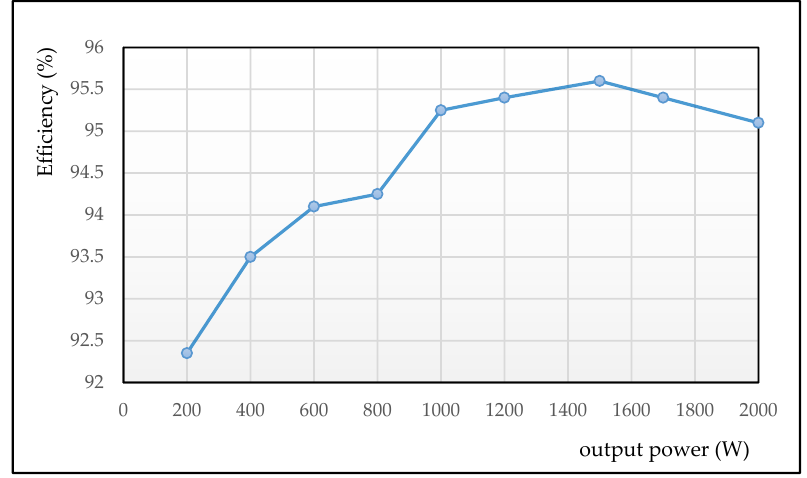
Figure 10. Converter efficiency curve with different loading condition at V in = 400 V.